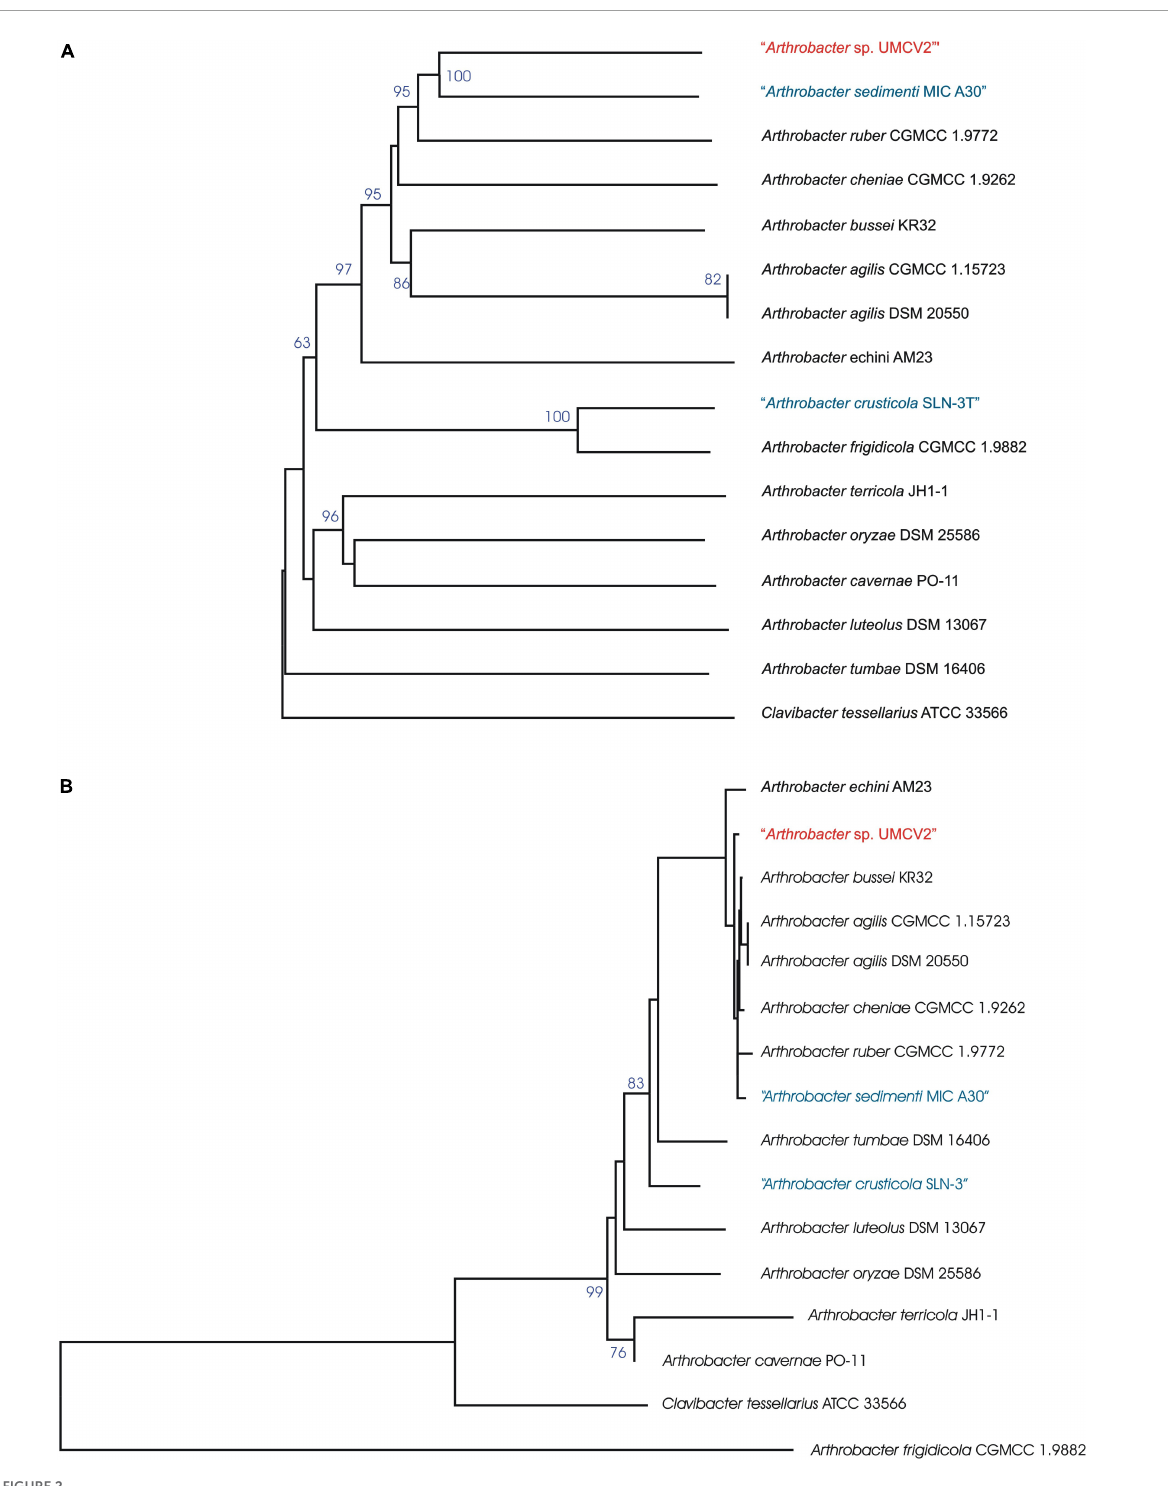
FIGURE2 Arthrobacter sp. UMCV2 phylogenetic tree based on the genomic (A) and (B) 16S rRNA gene sequences. The trees were inferred from genome BLAST distance phylogeny (GBDP) distances. The branch lengths were scaled in terms of GBDP distance formula d5. The numbers above branches are GBDP pseudo-bootstrap support values > 60% from 100 replications, with average branch support of 77.4% for genomic tree and 57.2% for 16S rRNA gene sequences tree. The trees were rooted at the midpoint. Species in blue were mentioned as not validly published by the DSMZ server https://lpsn.dsmz.de/ at the time of